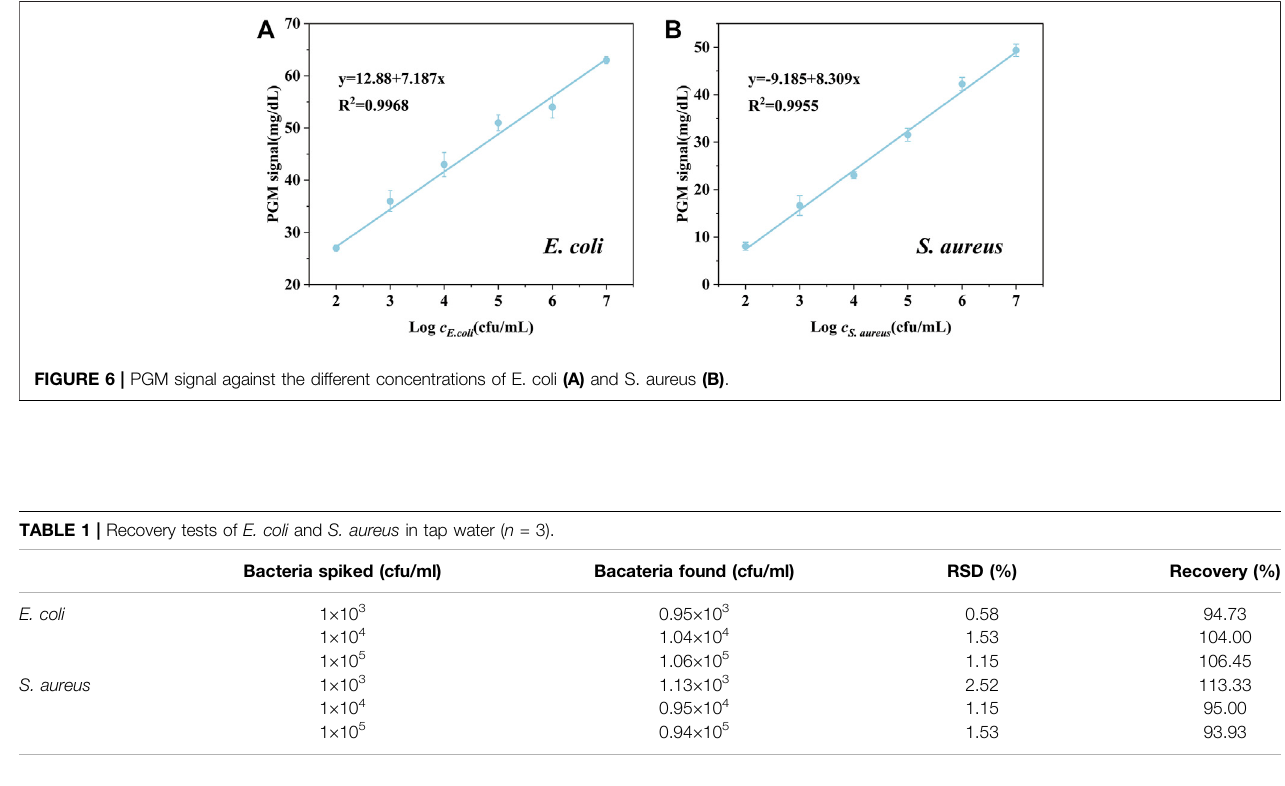
Frontiers in Bioengineering and Biotechnology |